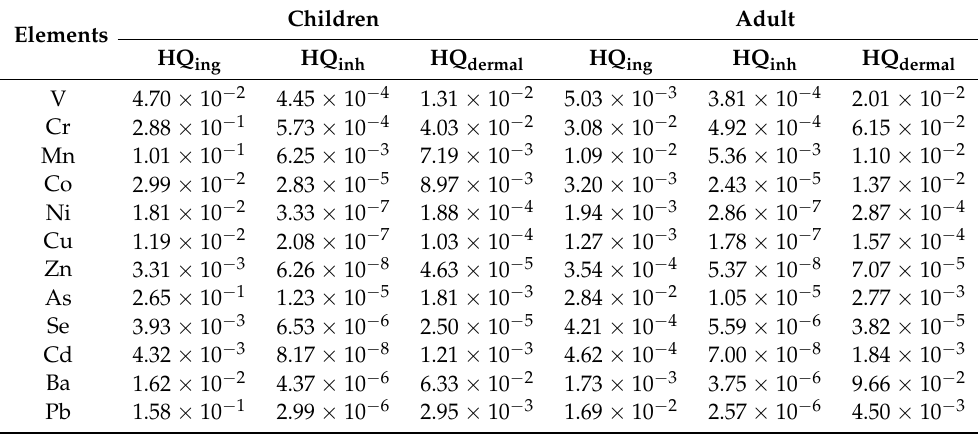
Table 6. HQ ij for different intake